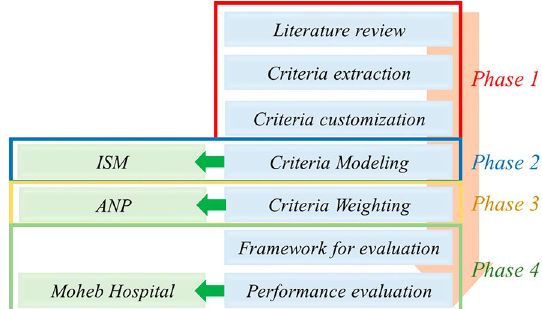
Figure 1. Research